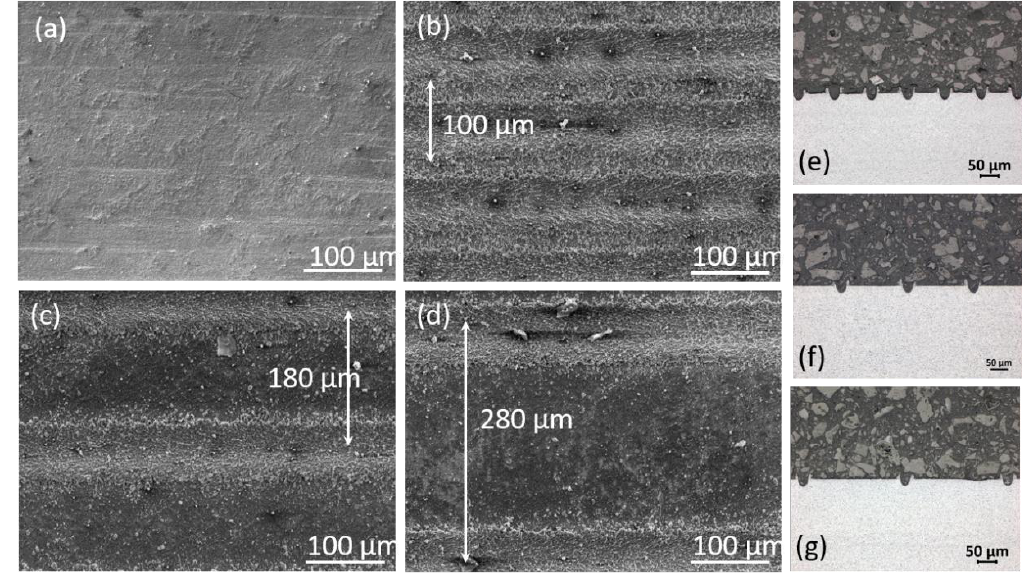
Figure 1. SEM images ( a – d ) and light microscopy images ( e – g ) of ( a ) the as-received unprocessed Ti-6Al-4V surface and laser-textured Ti-6Al-4V surfaces with different scan line separations: ( b , e ) 100, ( c , f ) 180 and ( d , g ) 280 μ m.